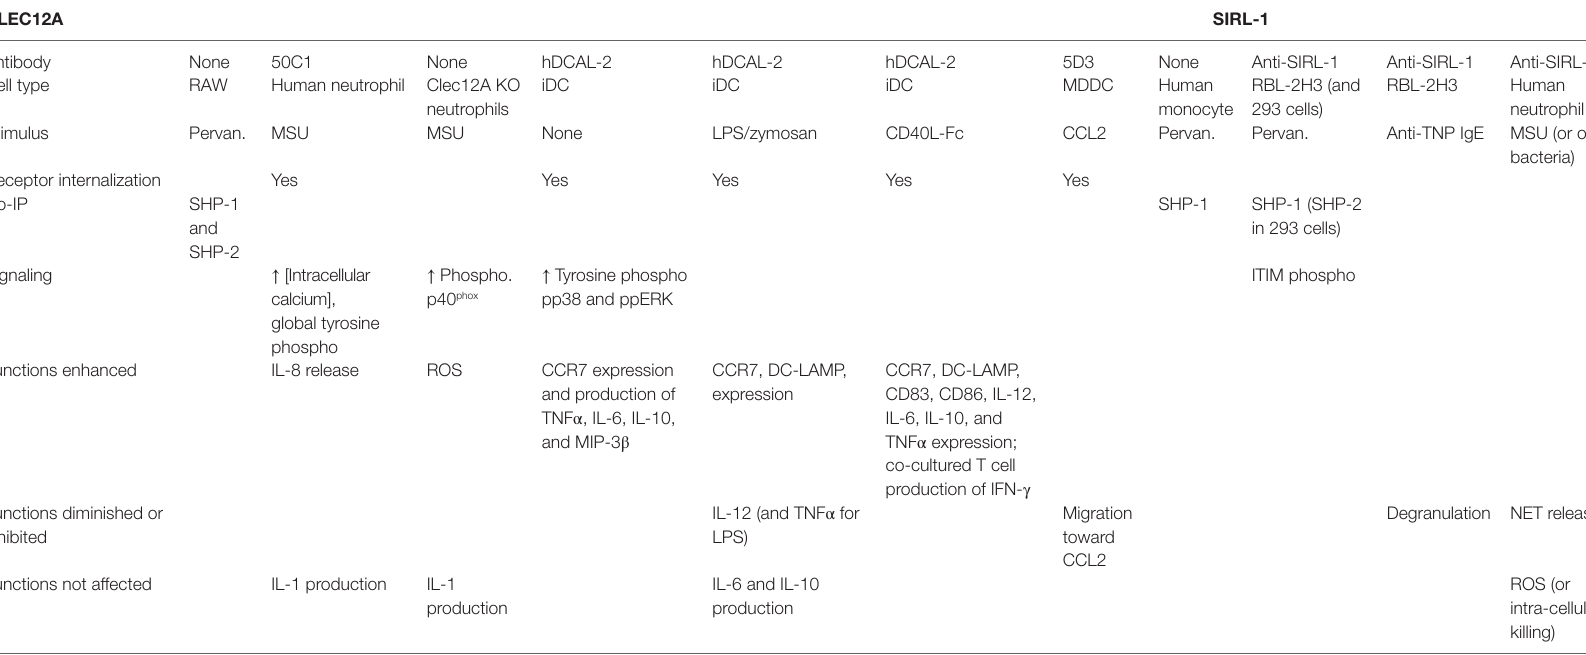
The studies were chosen according to the insight they provide on the molecular mechanisms governing CLEC12A and SIRL-1 function. The information in this table does not cover all the published findings on these receptors. Additional references can be found in the text. The signaling events downstream of both receptors and their effect on cell function depend on the cellular context and type of